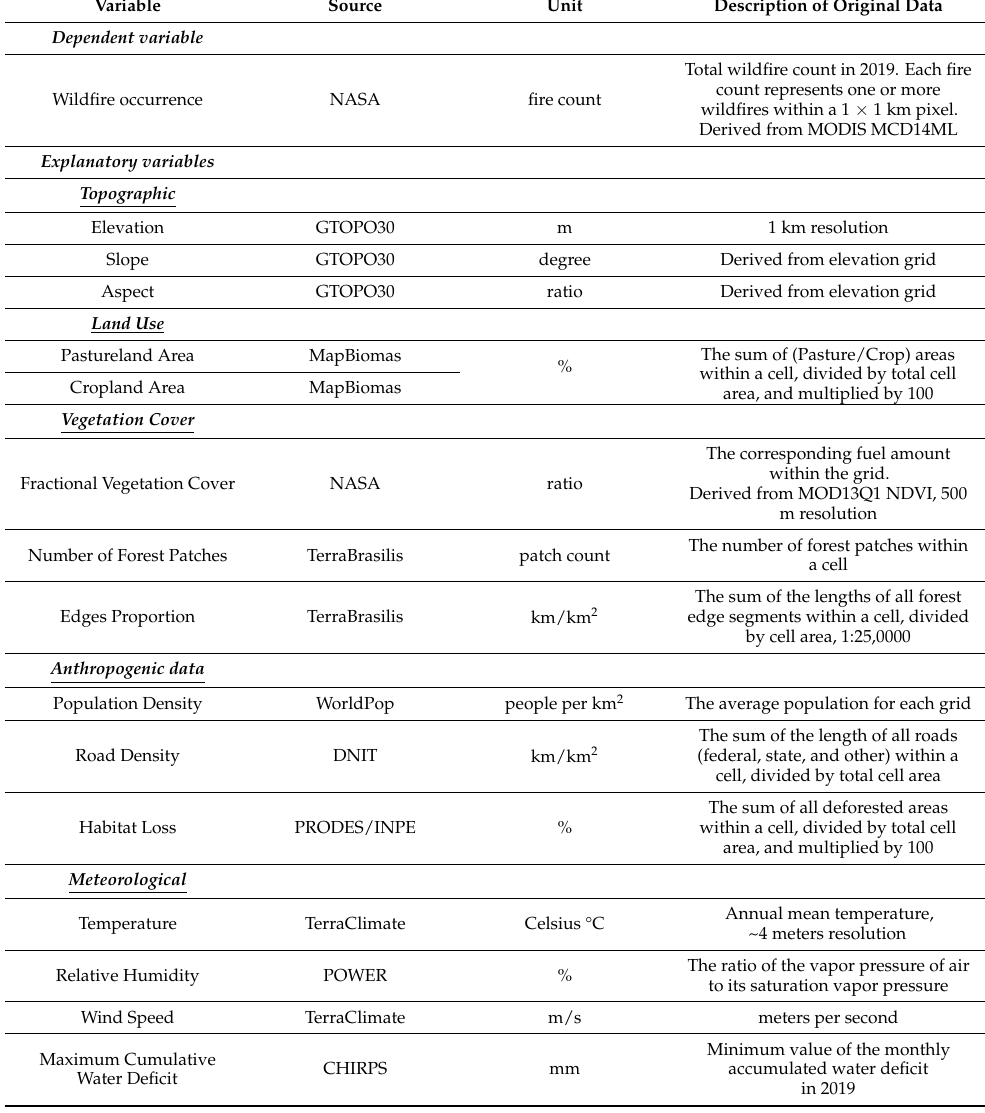
where θ is the degree of aspect and the range is 0–360 ◦ . The values of the aspect index ranged from − 1 (southward) to 1 (northward). Table 1. Sources and descriptions for